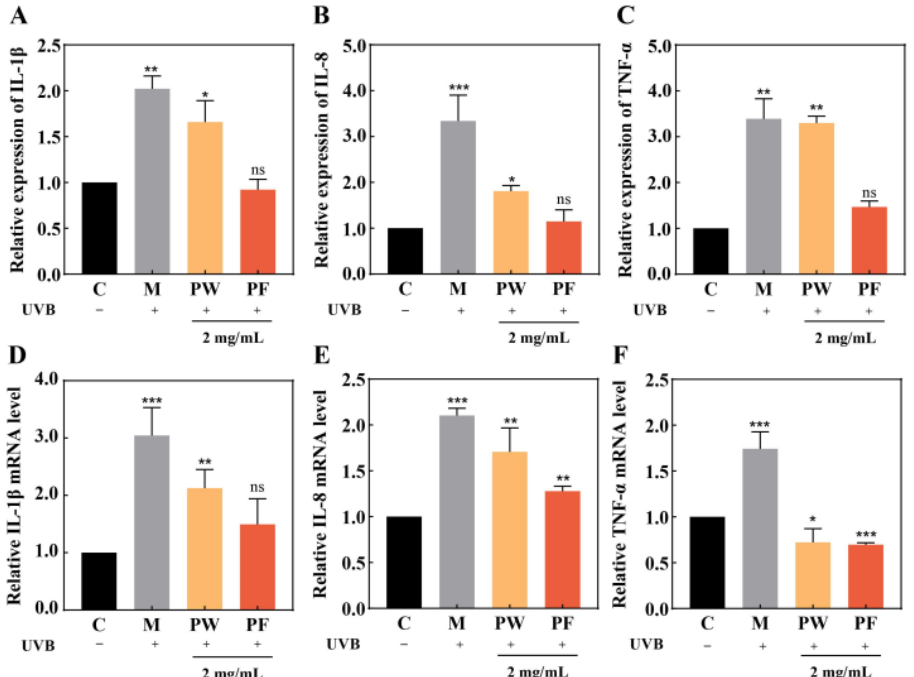
Figure 6. Effects of 2 mg/mL of PF and PW on inflammatory factor activity and relative mRNA expression in HaCaT cells. ( A , D ) IL-1 β activity and mRNA expression levels; ( B , E ) IL-8 activity and mRNA expression levels; ( C , F ) TNF- α activity and mRNA expression levels. PW: Passiflora edulis Sims peel water extract. PF: Passiflora edulis Sims peel fermentation broth. C: control group. M: UVB damage model group. Each value is expressed as mean ± SD ( n = 3). (*: p < 0.05, **: p < 0.01, ***: p < 0.001, ns > 0.05, versus control group).